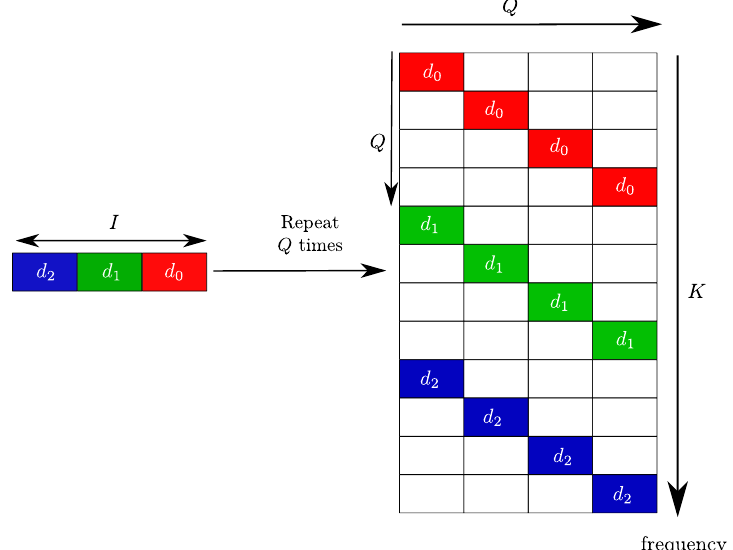
Figure 3. Example: QPSK symbols repetition for